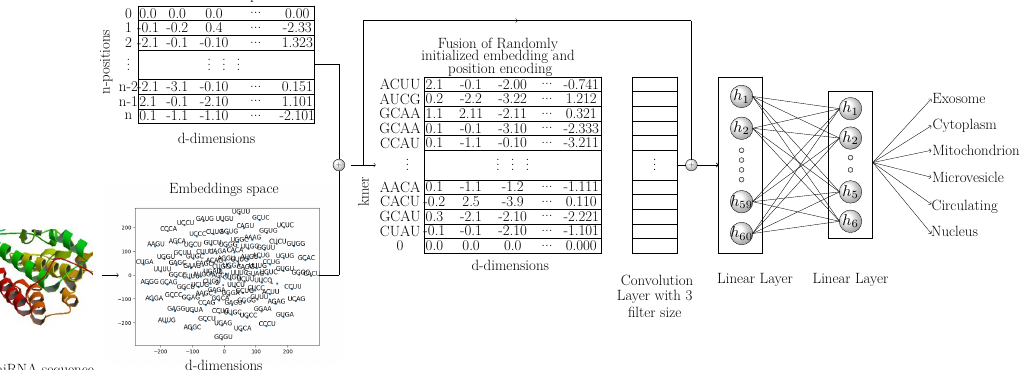
Figure 2. Graphical representation of the proposed MirLOcPredictor, where initially, k-mers of the miRNA sequence are passed to the embedding module that randomly generates 120 dimensional vector for each k-mer in parallel. The position encoding module captures the positions of k-mers in a given sequence. Randomly generated embeddings of the k-mers of sequence and positional information are fused, and final vectors are passed to the convolutional layer to extract discriminative features. The extracted features are passed to fully connected